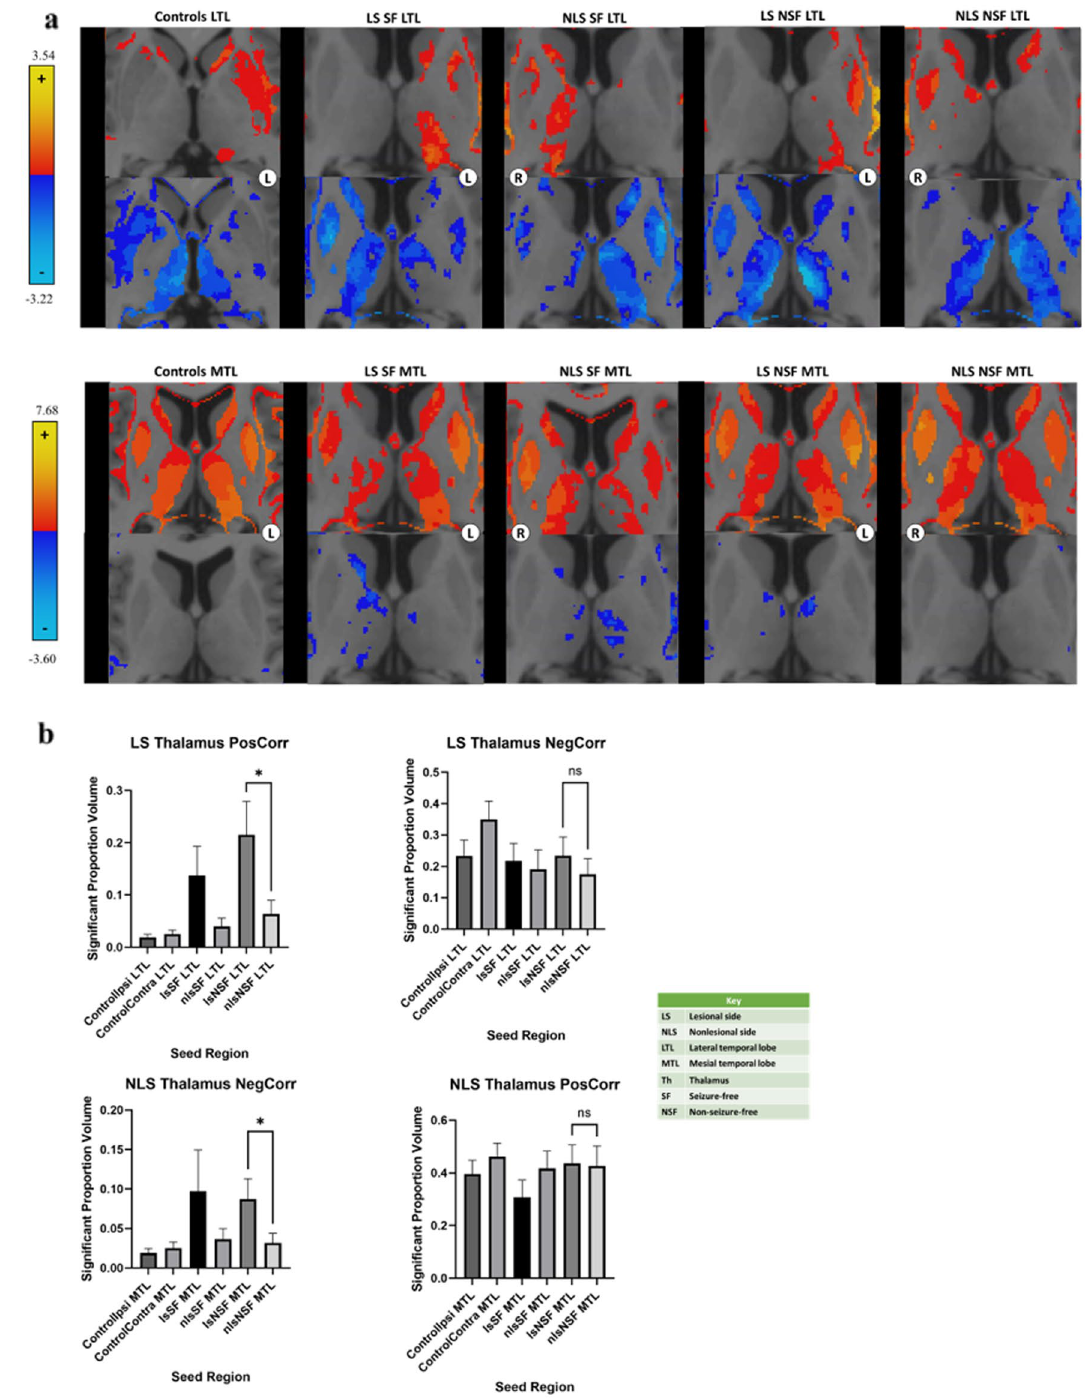
Figure 4. Combined heatmaps from the LTL and MTL of SF and NSF MTS patients. ( a ) Heatmaps of correlations from the LTL (top) and MTL (bottom) to the thalamus are shown. Heatmaps of patients with mTLE with MTS with a right-sided focus were mirrored so that the focus of all patients was on the anatomical left side for visualization. These were combined with heatmaps from patients with a left-sided MTS focus. Regions with z > 2.5 or z < − 2.5 are shown. Images are displayed in radiographic orientation. The anatomic left and right sides of the images are marked with L and R; the side that was chosen as the seed is the one marked on the image. ( b ) Comparisons between connectivity from the LS and NLS LTL (top) and MTL (bottom) to the thalamus are shown based on laterality of connections. ControlIpsi shows connectivity from the temporal lobe seed to the ipsilateral thalamus; ControlContra shows connectivity from the temporal lobe seed to the contralateral thalamus. Correlations with significant differences are marked in the graphs with *. Selected nonsignificant differences are marked with “ns” for